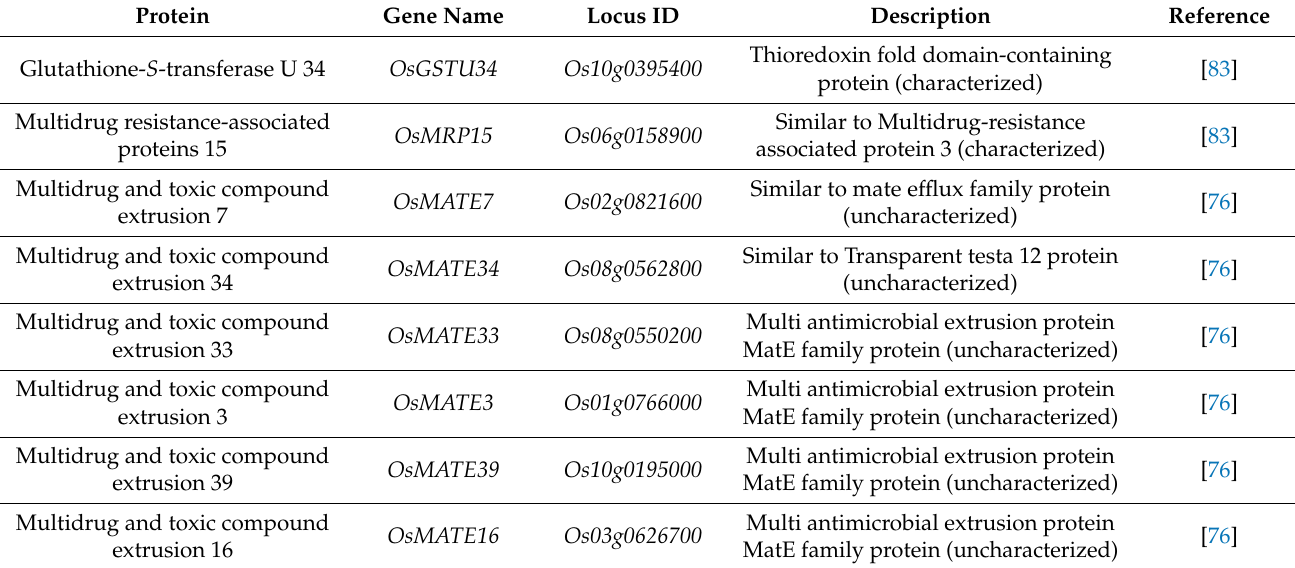
Table 5. Anthocyanin transporter genes in